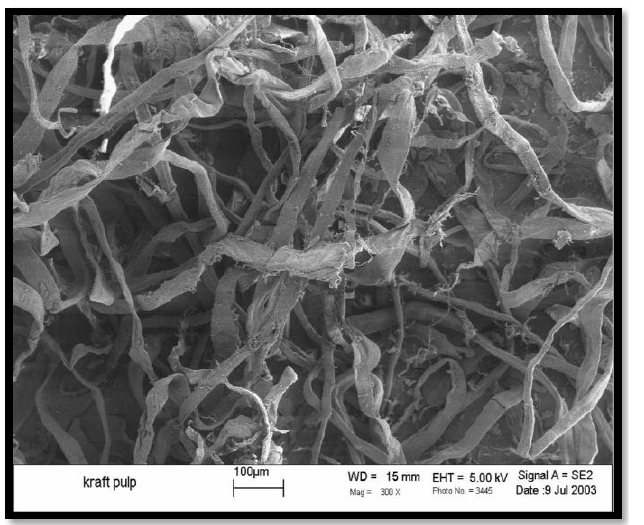
Figure 4. SEM image of kenaf bast fiber. Reprinted/adapted with permission from Ref. [49].